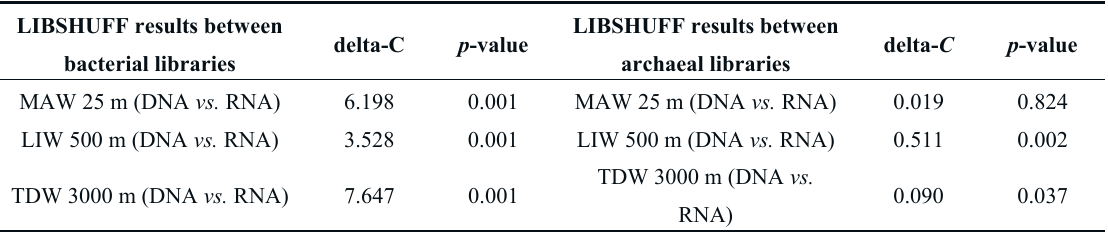
Table 3. LIBSHUFF results between bacteria and archaeal clone libraries obtained from different depths in Station Vector; (D: 16S rDNA-derived library; R: 16S rRNA-derived